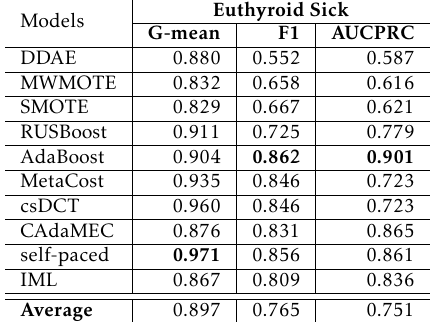
Table 7. Overall Results for Euthyroid Sick Dataset